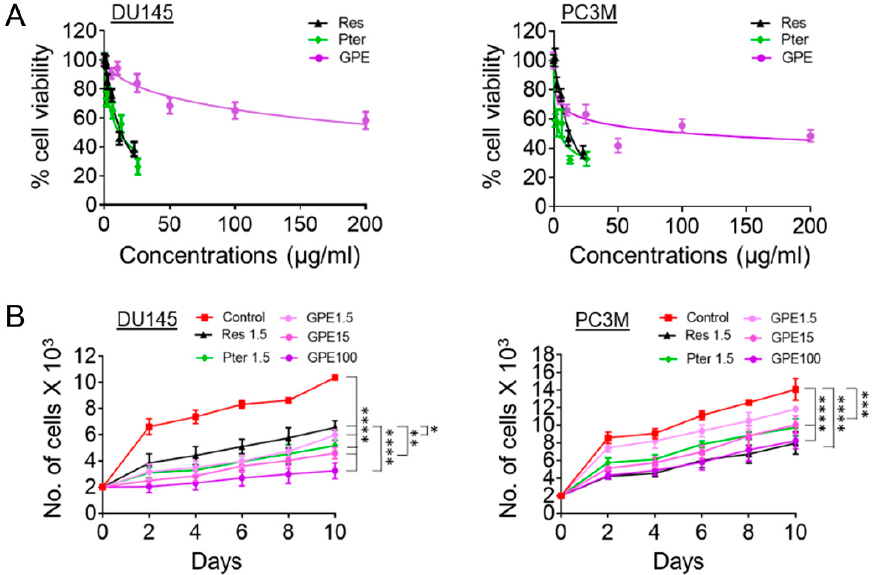
Figure 1. Effects of GPE on cell viability and cell proliferation. ( A ) Cell viability analysis of DU145 (left) and PC3M (right) prostate cancer cells treated with GPE (2–200 µ g/mL), Res (1.14–22.8 µ g/mL), and Pter (1.28–25.6 µ g/mL). Data represent the mean ± scanning electron microscopy (SEM) of three independent sets of experiments. ( B ) Proliferation assay of DU145 (left) and PC3M (right) cells after treatment with GPE (1.5; 15; 100 µ g/mL) and Res and Pter (1.5 µ g/mL) for 10 days. Data represent the mean ± SEM of three independent sets of experiments. * p < 0.05, ** p < 0.01, *** p < 0.001, and **** p < 0.0001 (one-way analysis of variance (ANOVA)) were assessed as significant differences between treated and Ctrl vehicle cells.